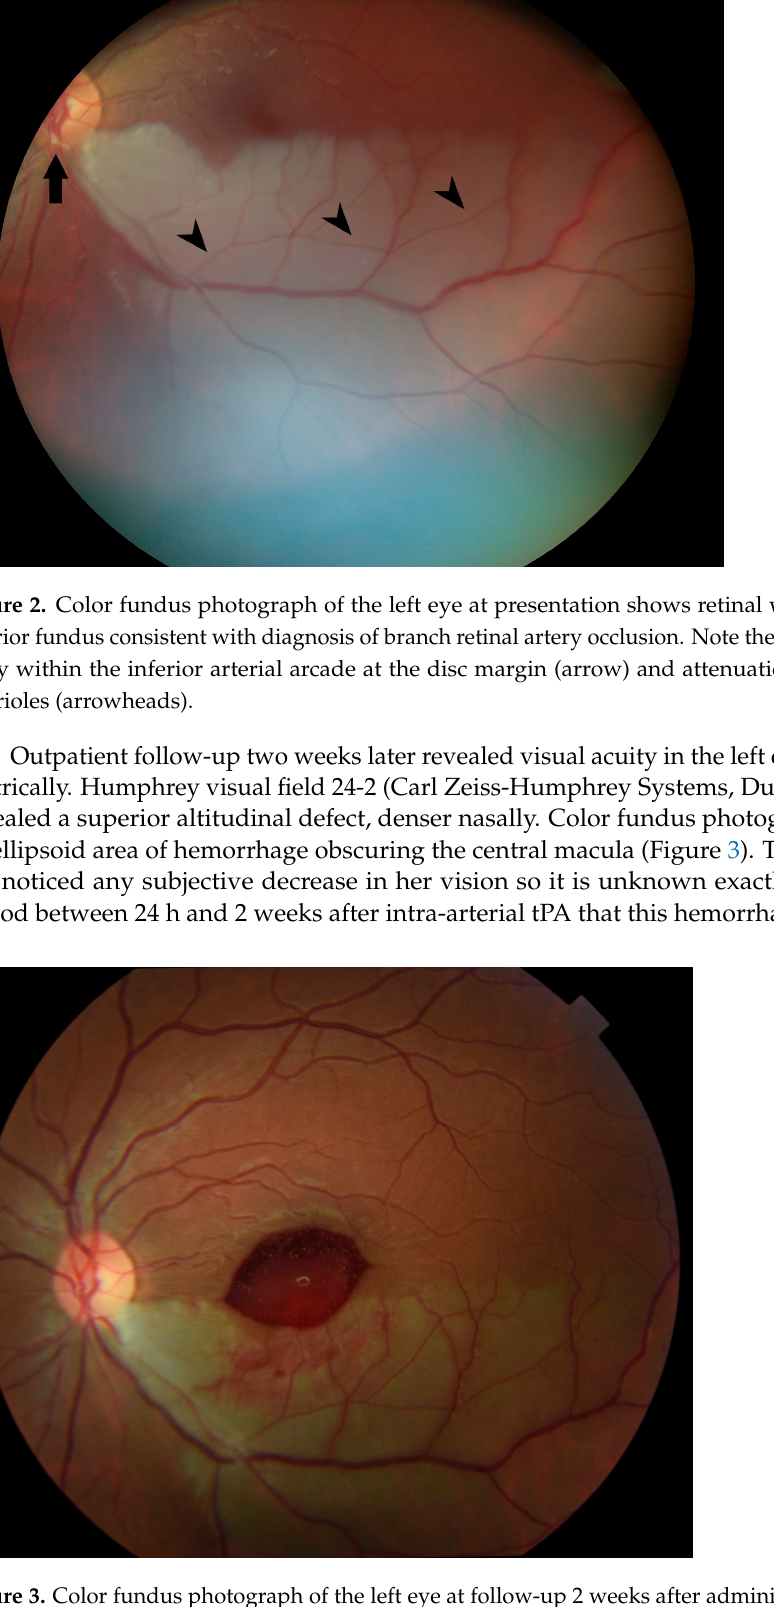
Figure 4. Color fundus photograph of the left eye at 7 weeks follow-up shows significant improve- ment of inferior retinal whitening and significant resorption of central macular hemorrhage. Note the yellowish superficial deposit over the fovea, consistent with residual dehemoglobinized blood.